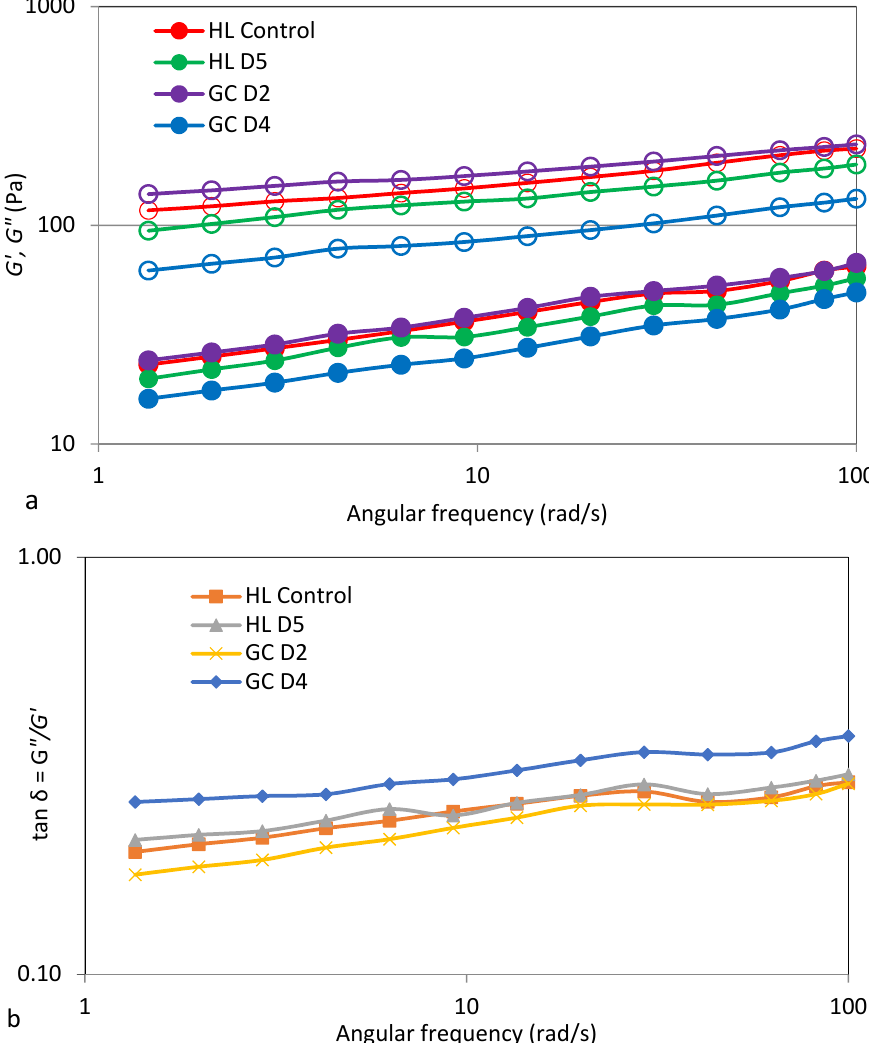
Figure 3. Mechanical spectra ( a ) G ’ stands for empty markers, G ” filled markers, and tan δ dependence on angular frequency ( b ) of selected potato starch gels.